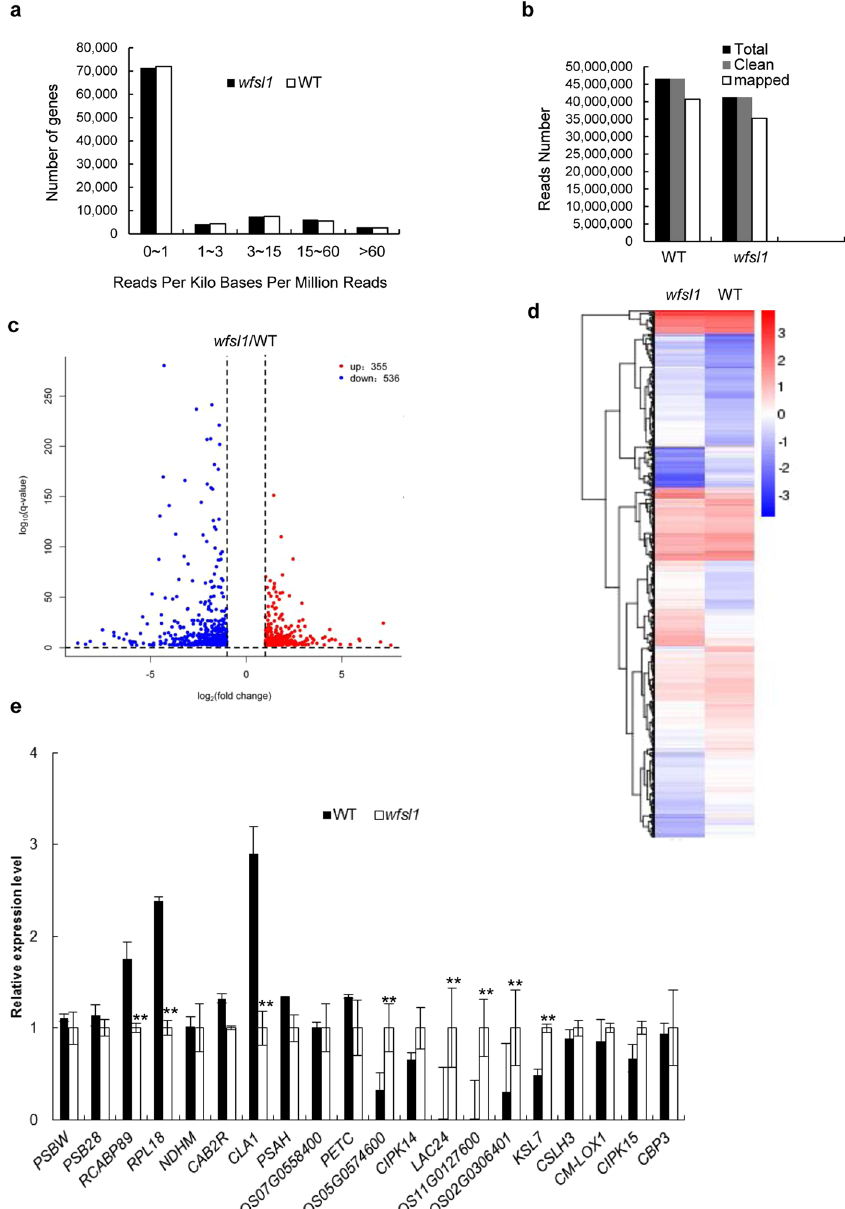
Figure 6. RNA-seq analysis of wild type and wfsl1 . mRNA was purified from total RNA isolated from tillering stage plants of wild type and wfsl1 using poly-T oligo-attached magnetic beads. cDNA was synthesized using random hexamer primers. The library was constructed and sequenced using an Illumina Hisequation 2000. ( a ) Numbers of genes sorted according to their expression level. ( b ) Read numbers of wild type and wfsl1 sequences. ( c ) Volcano plot showing the overall alterations in gene expression in wild type and wfsl1 . ( d ) Cluster analysis of differently expressed genes in wild type and wfsl1 Red represents high expression genes. Blue represents low expression genes. ( e ) qRT-PCR analysis differently expression genes of RNA-seq. 20 up-regulated or down-regulated genes were tested. Error bars represent the SD from three independent experiments (Student’s t -test, * P < 0.05; ** P <